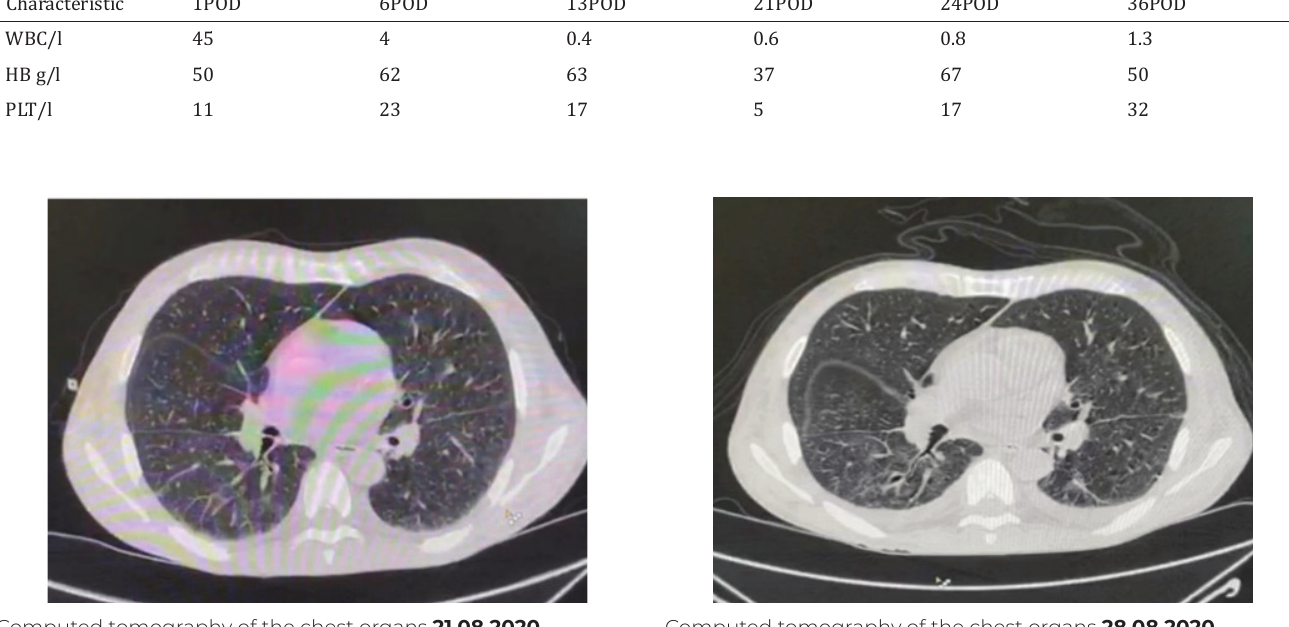
Computed tomography of the chest organs Figure 2. Figure 2 Bilateral polysegmental pneumonia, bilateral hydrothorax. In comparison with the CT scan of 08.21. there is an increase in the degree of infiltration and the development of bilateral hydrothorax.